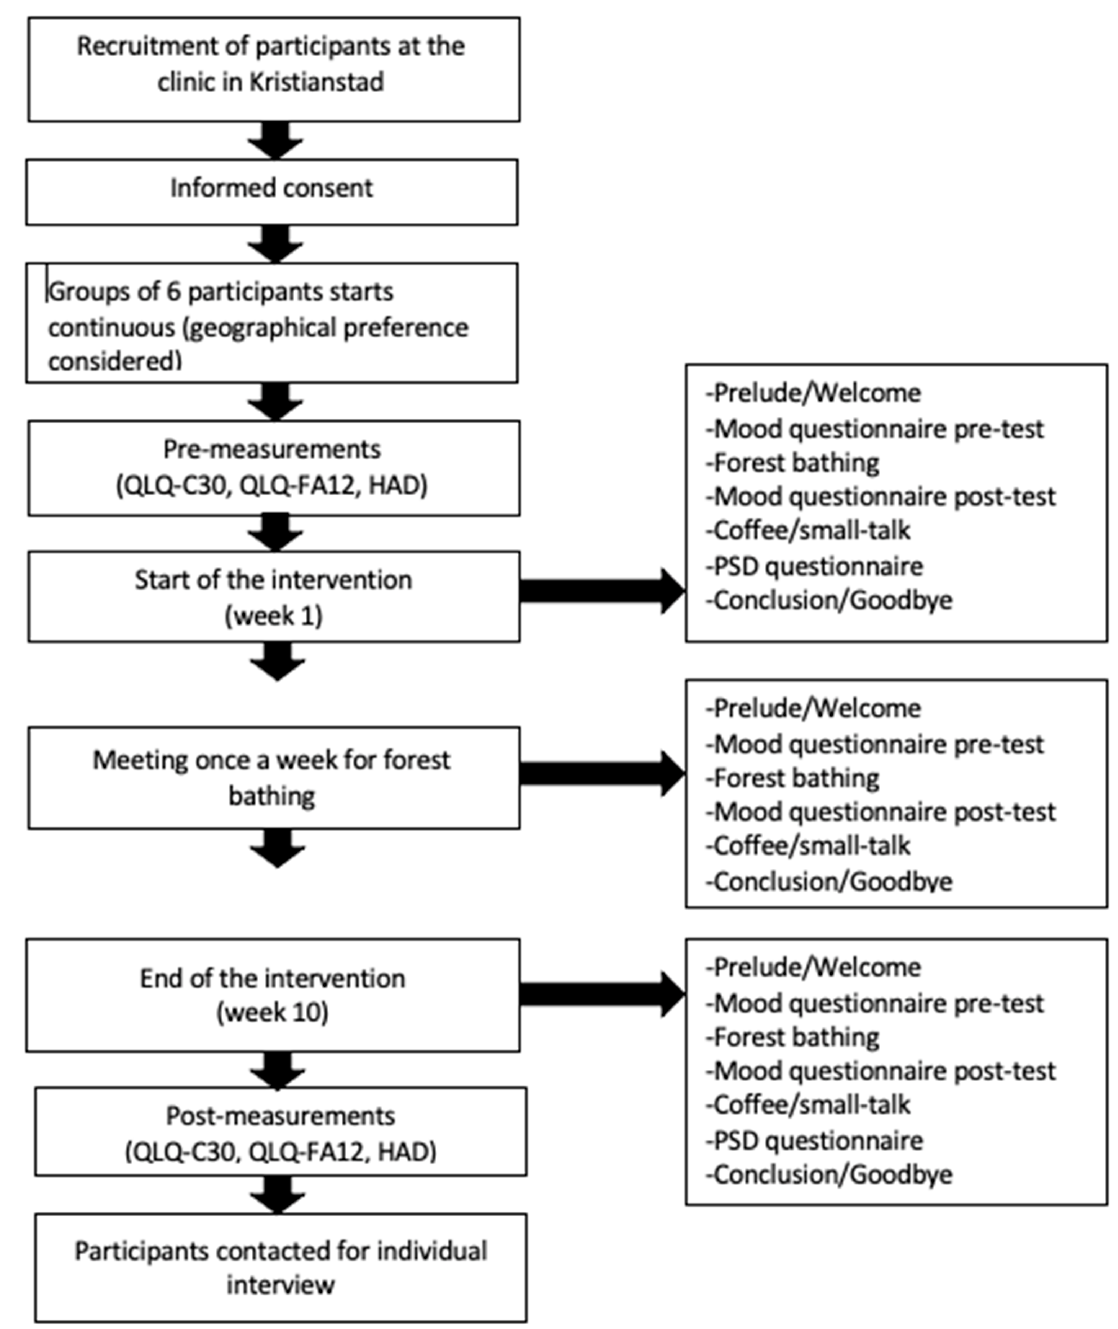
Figure 6. Overview of the study; recruitment of patients to the study, from start to the end of the intervention, including post–pre measurements and offer for voluntary interview.